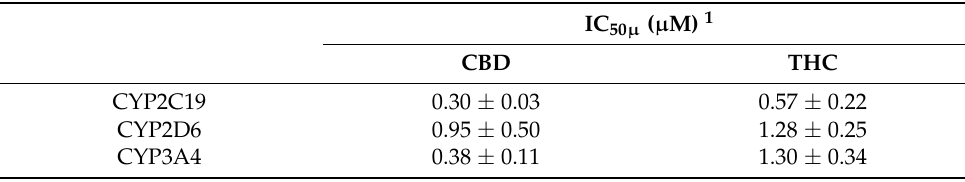
Table 1. Impact following tetrahydrocannabinol/cannabidiol administration on in vitro CYP enzyme activity